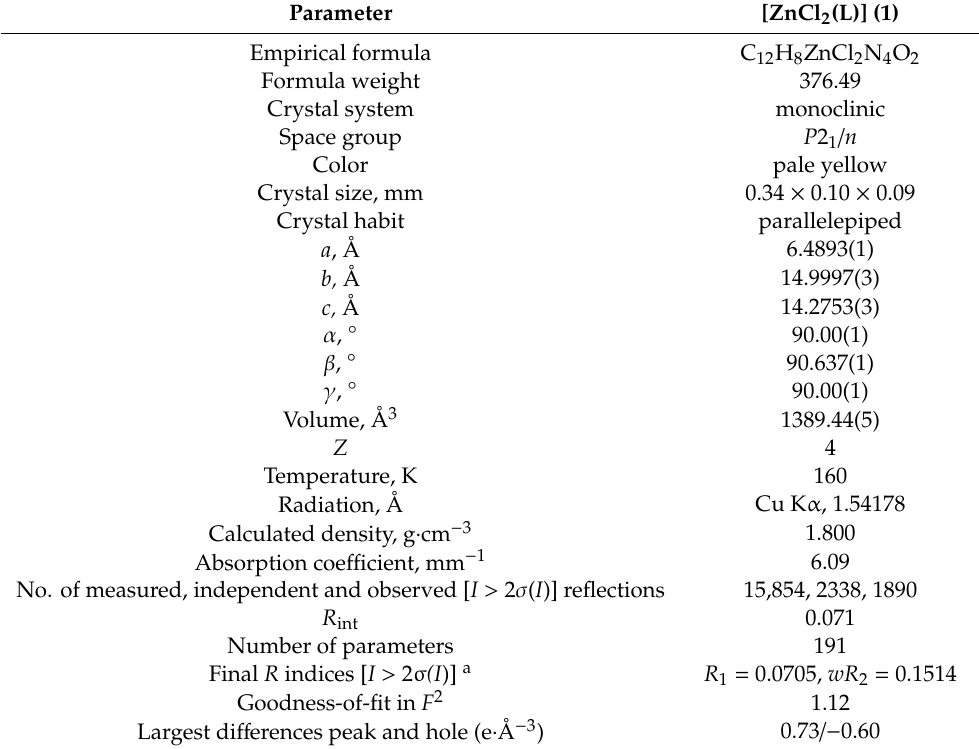
Table 1. Crystallographic data and structural refinement parameters for complex 1 .